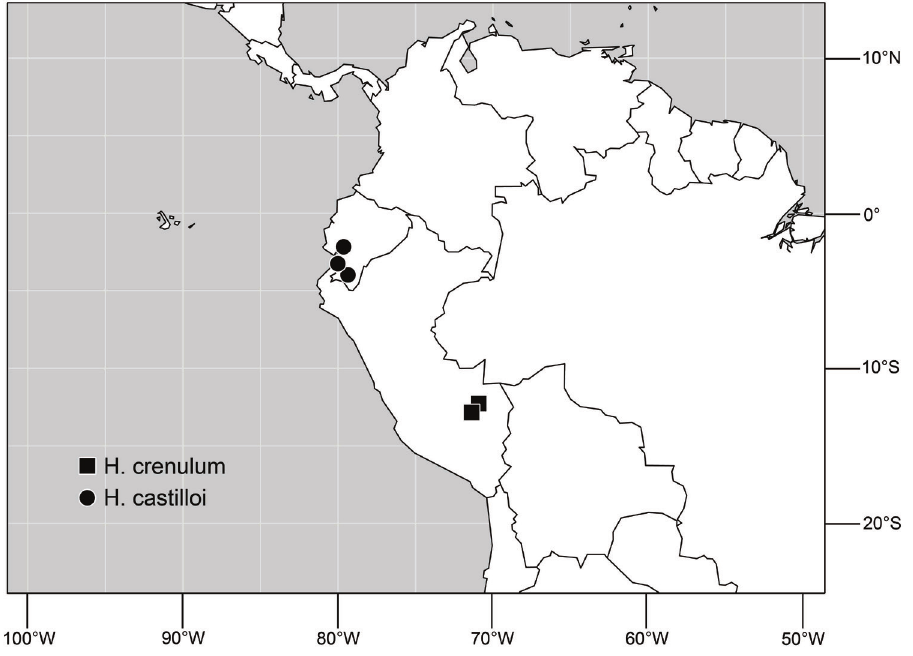
Figure 6. Distribution of Hydrochasma castilloi sp. n. and H. crenulum sp.